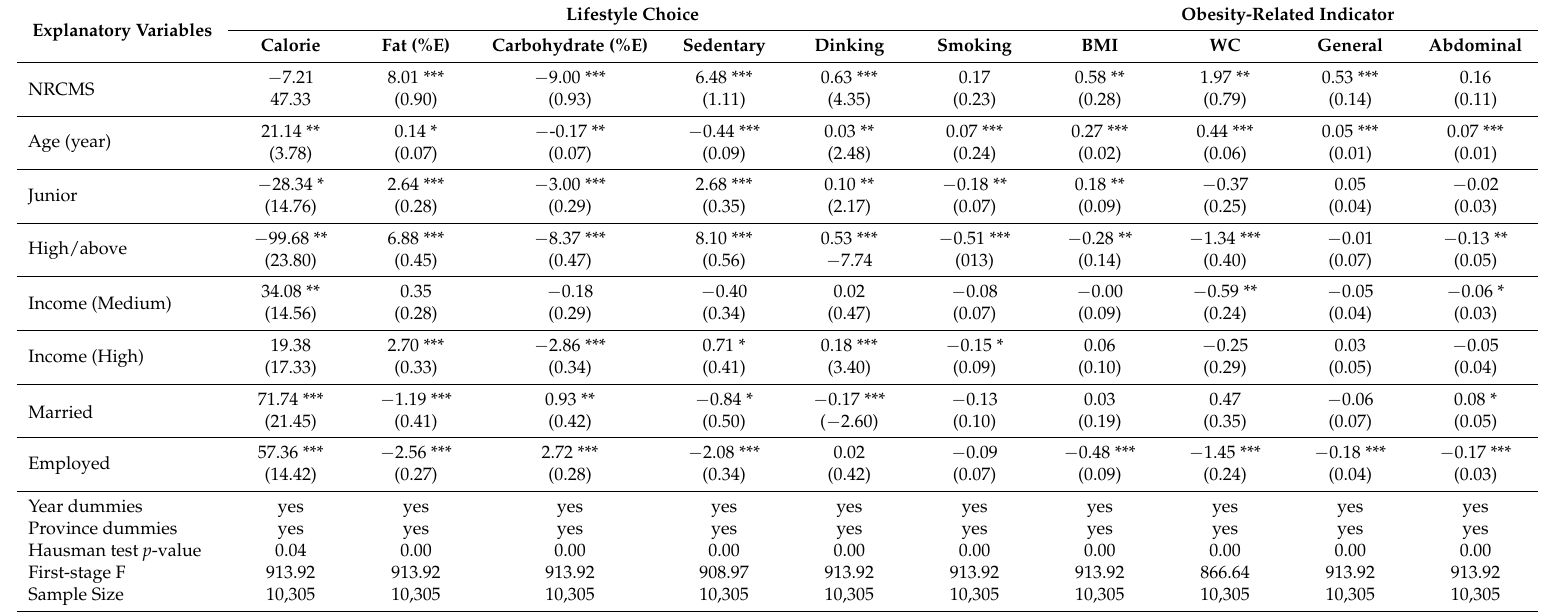
Table A3. Effects of the NRCMS on a female's lifestyle choice and being